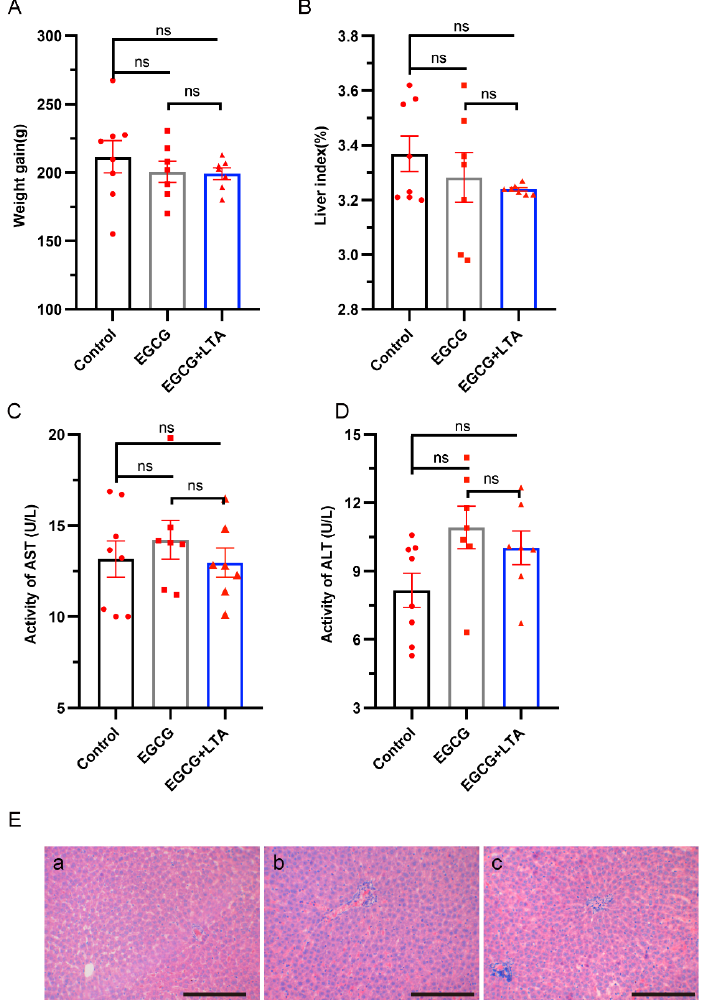
Figure 1. Neither EGCG nor the combination of EGCG and LTA (EGCG+LTA) was toxic to Rats. ( A ) Average weight gain of rats over 28 days. ( B ) Liver index of rats in different groups. Activities of serum AST ( C ) and ALT ( D ) among the three groups. ( E ) Hematoxylin and eosin staining of liver tissue sections (scale bar: 100 μ m): ( a ) control group, ( b ) EGCG treatment, and ( c ) EGCG+LTA treatment group. Values are expressed as the mean ± SE. ns: no significant difference.